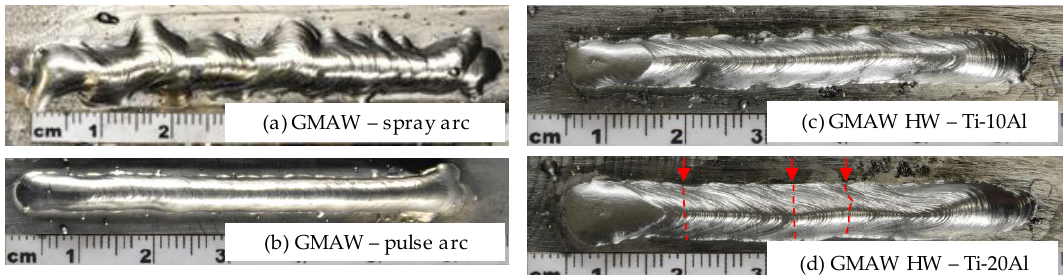
Figure 2. Investigations into the process behavior with ( a ) spray arc ( b ) and pulse arc welding regimes with GMAW process and in situ processing of Ti–Al alloys with ( c ) 10% Al and ( d ) 20% Al with pulsed GMAW and hot wire with resulting cold cracks (red